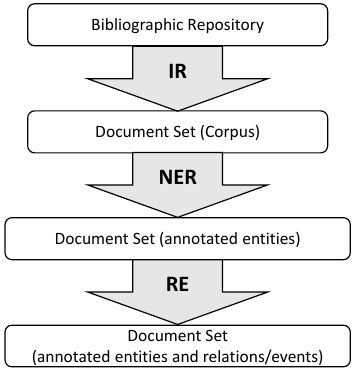
Figure 1: Generic pipeline for